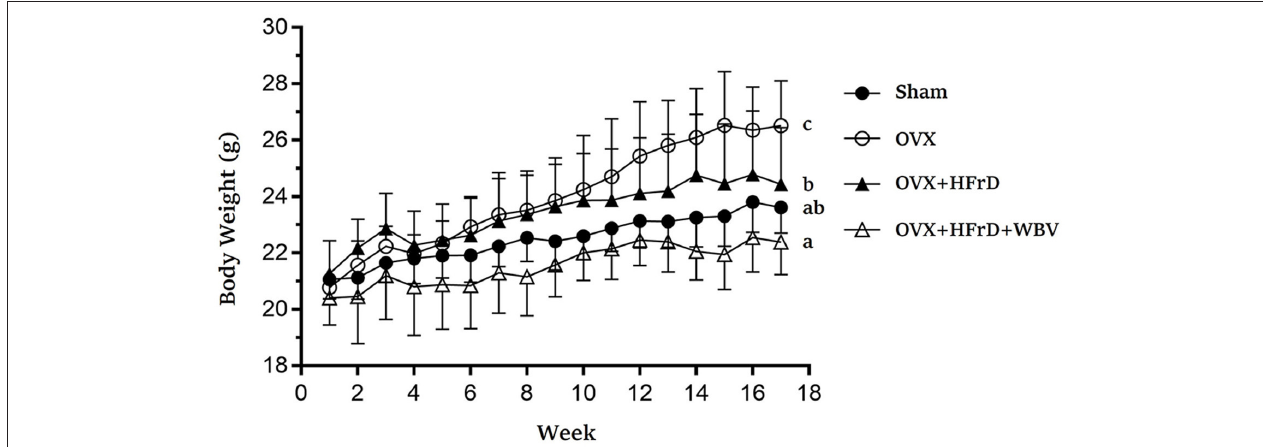
FIGURE 2 | The effects of whole-body vibration (WBV) combined with a high-fructose diet (HFrD) on ovariectomized (OVX) mice in terms of growth. The body weight of the mice was assessed every week for 16 weeks. Data are presented as means ± SD. Different superscript letters indicate significant differences ( P < 0.05), as indicated by a one-way analysis of variance.